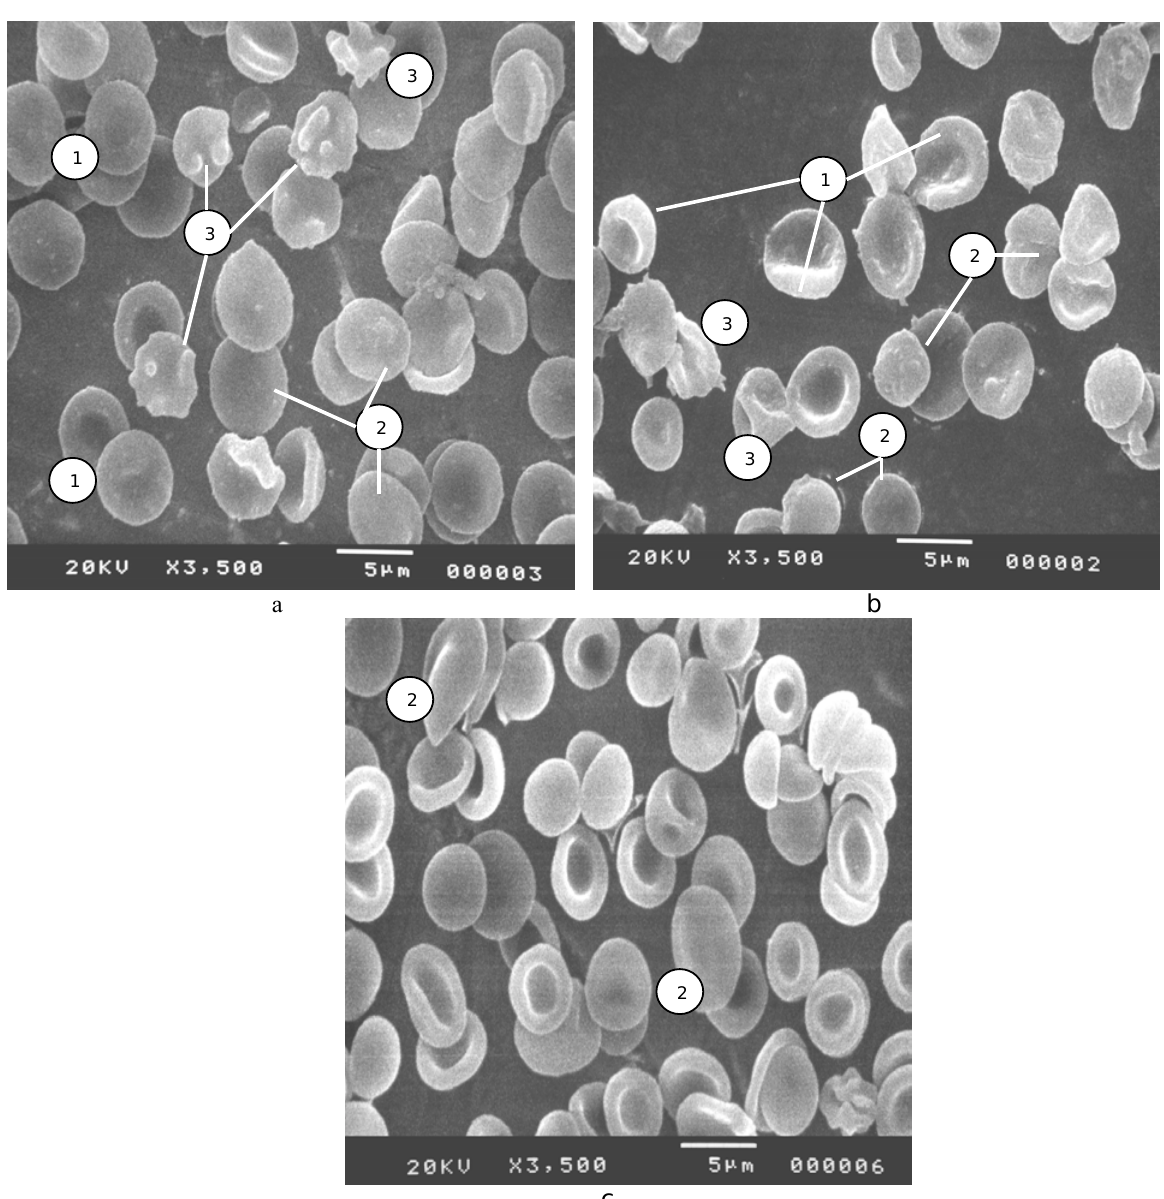
Fig. 1. Structural reconstruction of periphery erythrocytes in 1 st group (a), 2 nd group (b) and 3 rd group (c) after single maximal physical load. Legend: 1 – normal forms of erythrocytes; 2 – reversibly changed forms of erythrocytes; 3- irreversibly changed forms of erythrocytes. Method: scanning electronic microscopy (scale 3500:1).